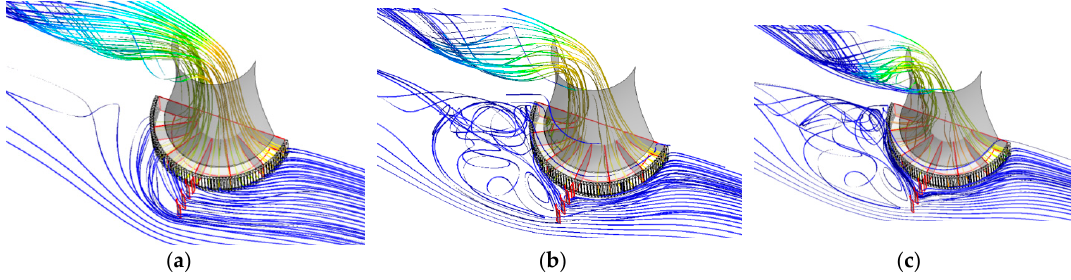
Figure 11. Streamlines colored by temperature for case D at various wind speeds. ( a ) at 4 m/s; ( b ) at 12 m/s; ( c ) at 20 m/s.